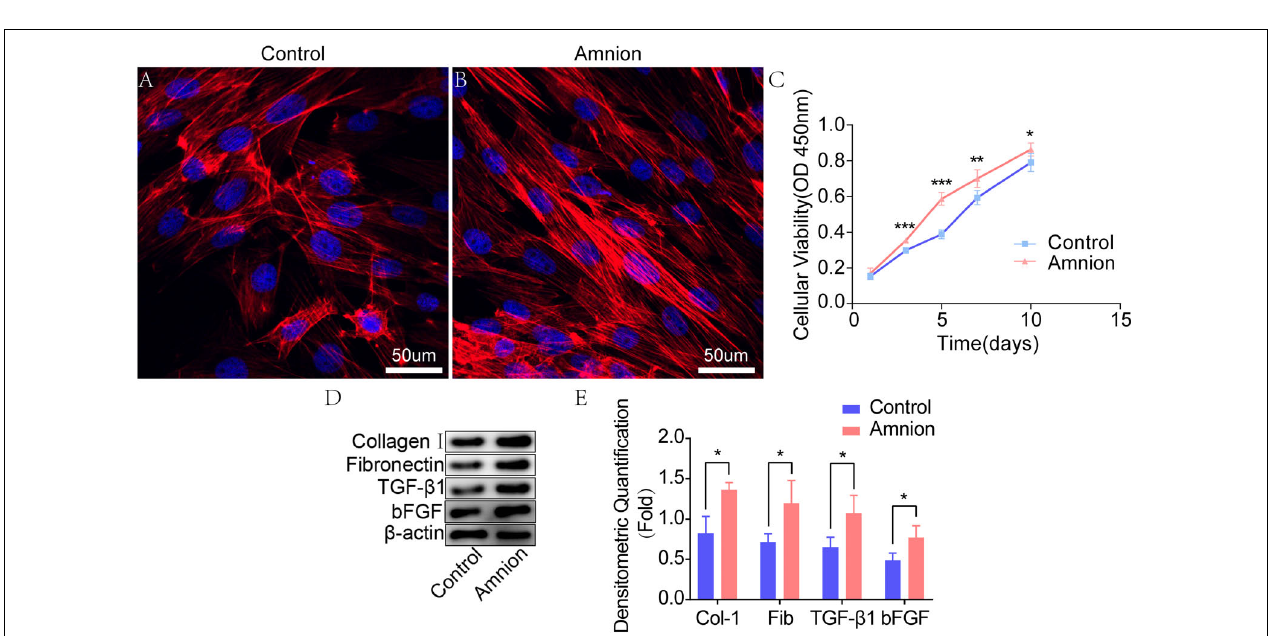
FIGURE 1 | The appearance of fresh amniotic membranes (A) . The epithelial cell layer of fresh amniotic membranes (B) and the histoarchitecture of the acellular amnion (C) observed by SEM. The cell structure was not detected and the intimal surface was rougher than that of the native amnion. (D) The remaining cellular DNA in the amnion and acellular amnion was measured using Quant-iT PicoGreen dsDNA Assay Kit. The total DNA content (351.5 ± 9.23 ug/mL) decreased significantly after the decellularization treatment when compared to the acellular amnion (15.66 ± 0.82 ug/mL). The epithelial cell layer of native amniotic membranes (E) . Hematoxylin-eosin (H&E) staining confirmed complete removal of epithelial cells (F) . *** p < 0.001.